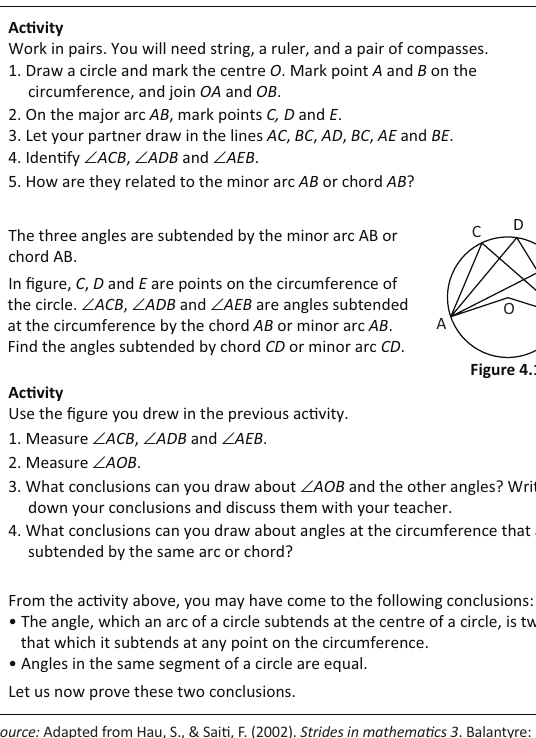
FIGURE 2: Empirical task on angle properties of the circle.